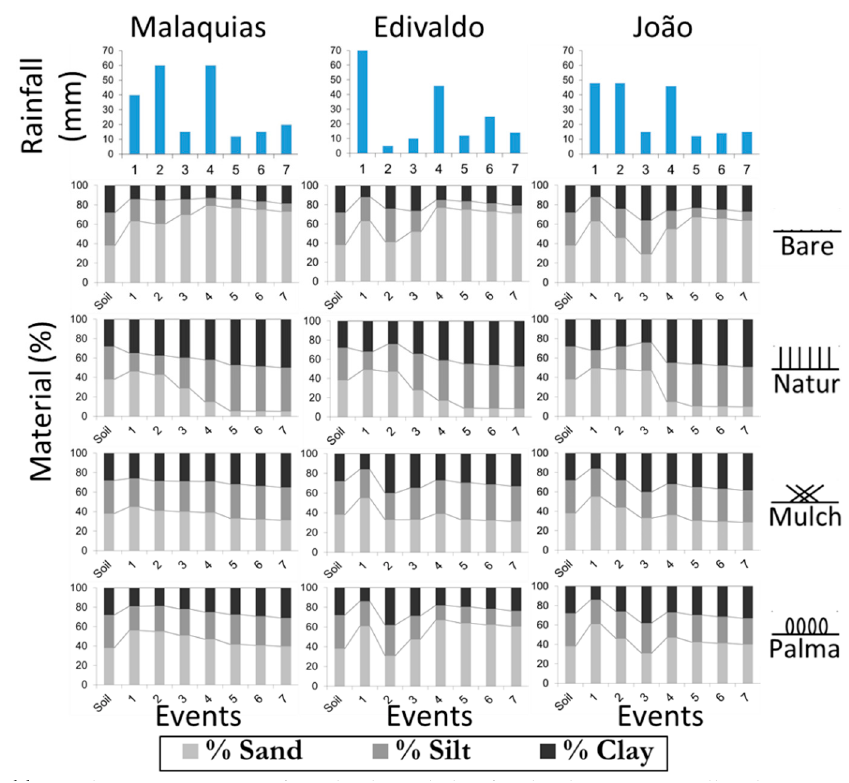
Figure 11. Tracking percentages of sand, silt, and clay for the three sites in all soil covers, together with the seven rainfall events that produced erosion in the plots.